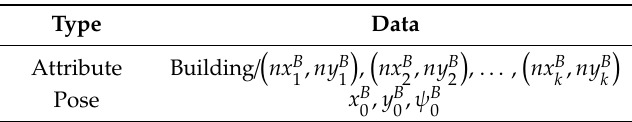
Table 2. Example of a building as the time-invariant object.